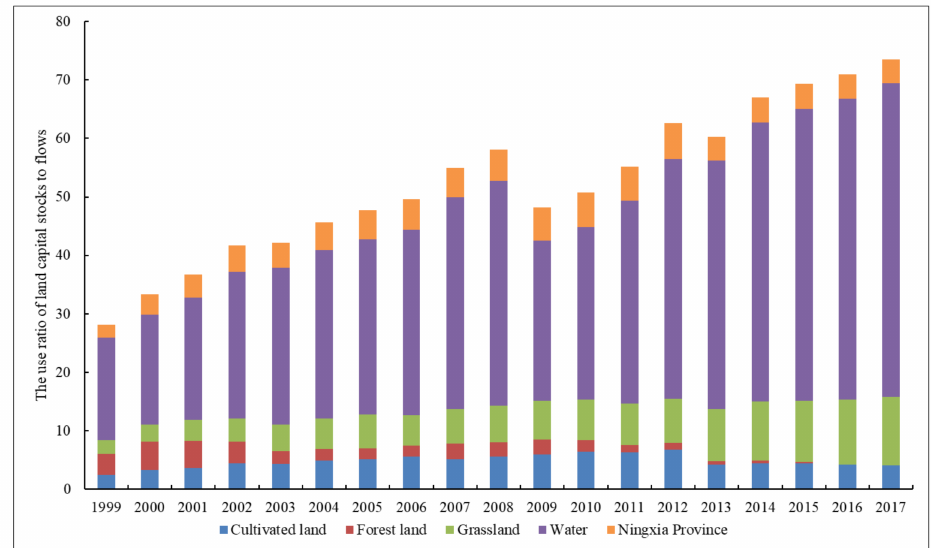
Figure 3. Changes in the UR sto of different land use types in Ningxia from 1999 to 2017. flo